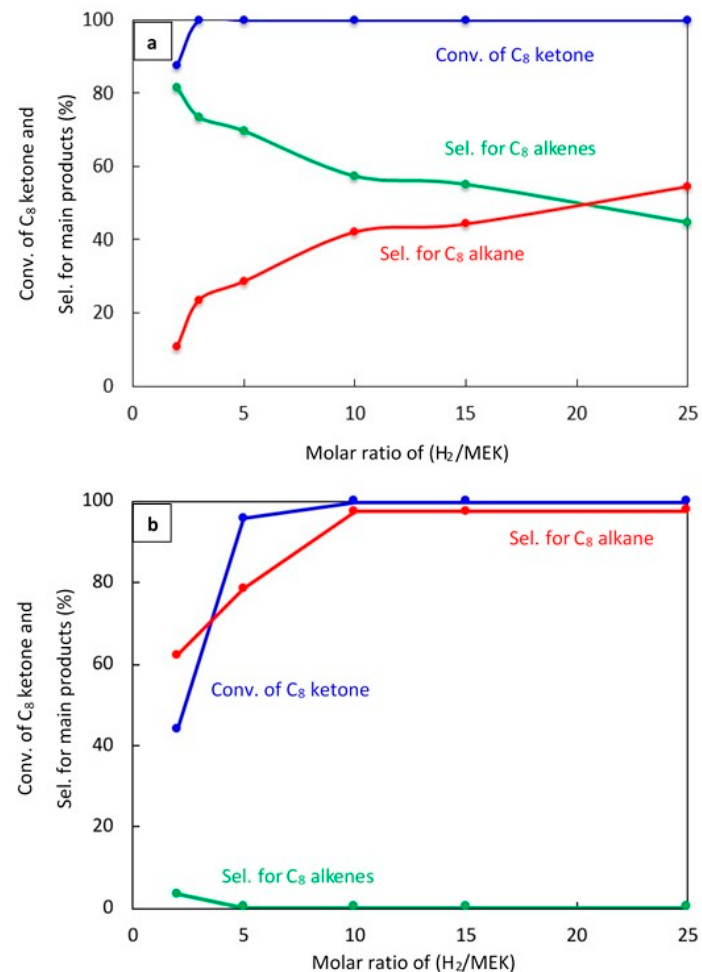
Figure 5. Catalytic results for the conversion of C 8 ketone to several products using different H 2 /C 8 ketone molar ratios using 0.5 g of the catalysts: ( a ) (20% Cu–Al 2 O 3 ), ( b ) (1% Pt–Al 2 O 3 ). Reaction conditions: reaction temperature, 220 °C; the total flow rate of H 2 and N 2 , 85 mL/min; the flow rate of H 2 and N 2 , 68.5 and 16.5 mL/min, respectively; the flow rate of C 8 ketone, 1 mL/h; the molar ratio of H 2 /C 8 ketone was varied from 2 to 25.